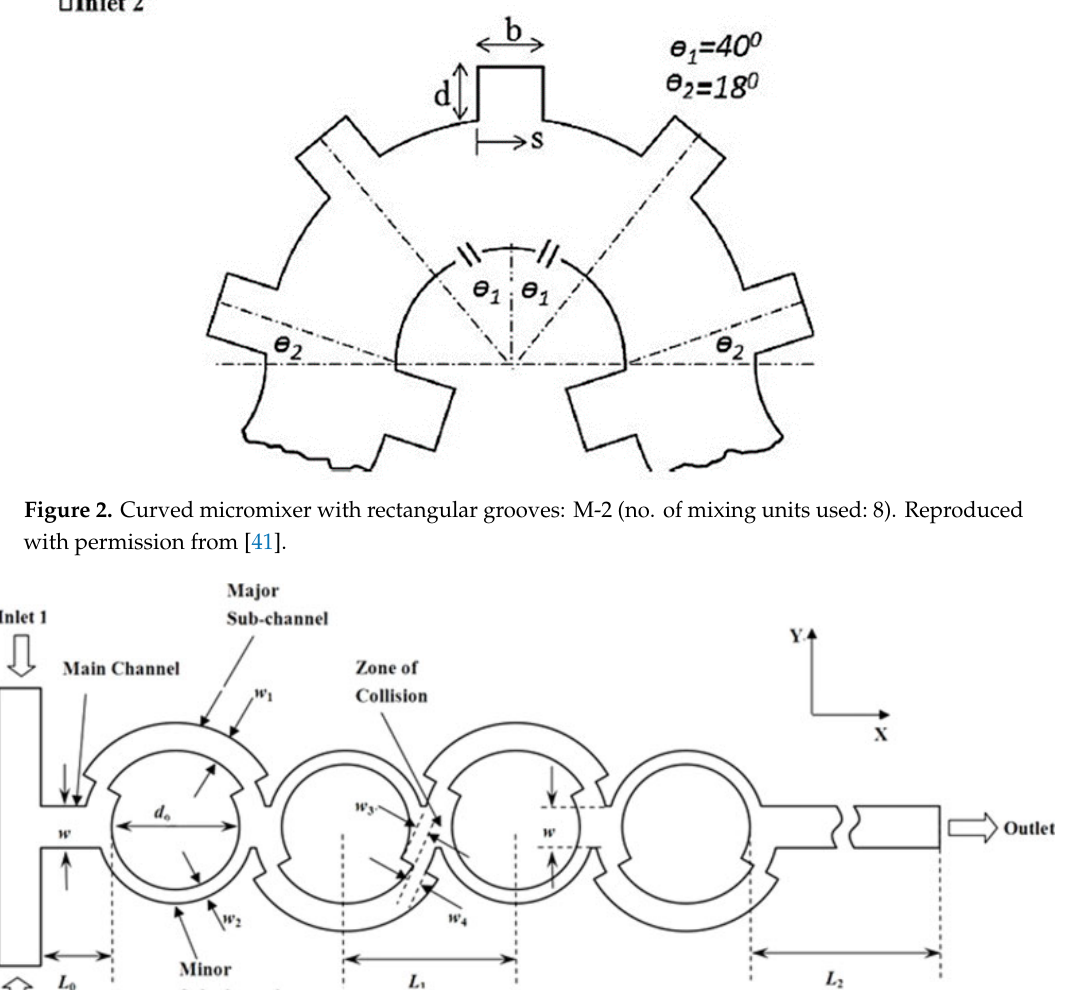
Figure 3. Modified P-SAR micromixer with dislocation sub-channels: M-3 (no. of mixing units used: 4). Reproduced with permission from [68]